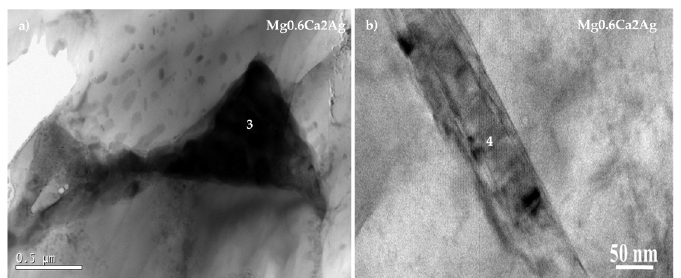
Figure 3. Transmission electron micrographs of the Mg0.6Ca2Ag alloy with locations of EDS analysis. ( a ) Mg0.6Ca2Ag 0.5 µ m and ( b ) Mg0.6Ca2Ag 50 nm.